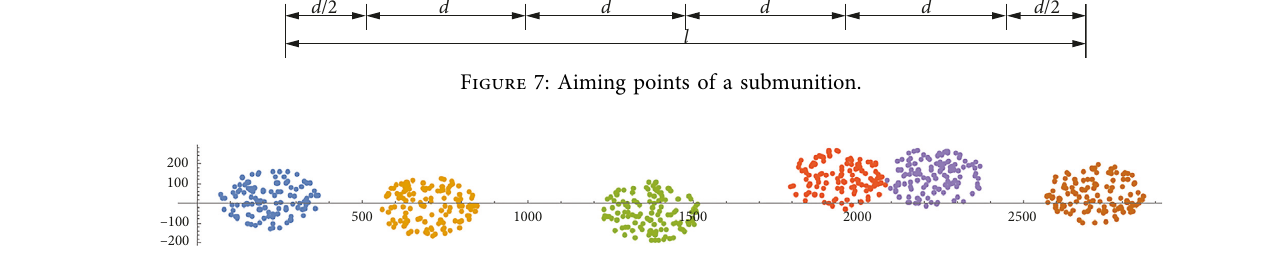
Figure 8: Simulation of the drop point of subprojectiles.